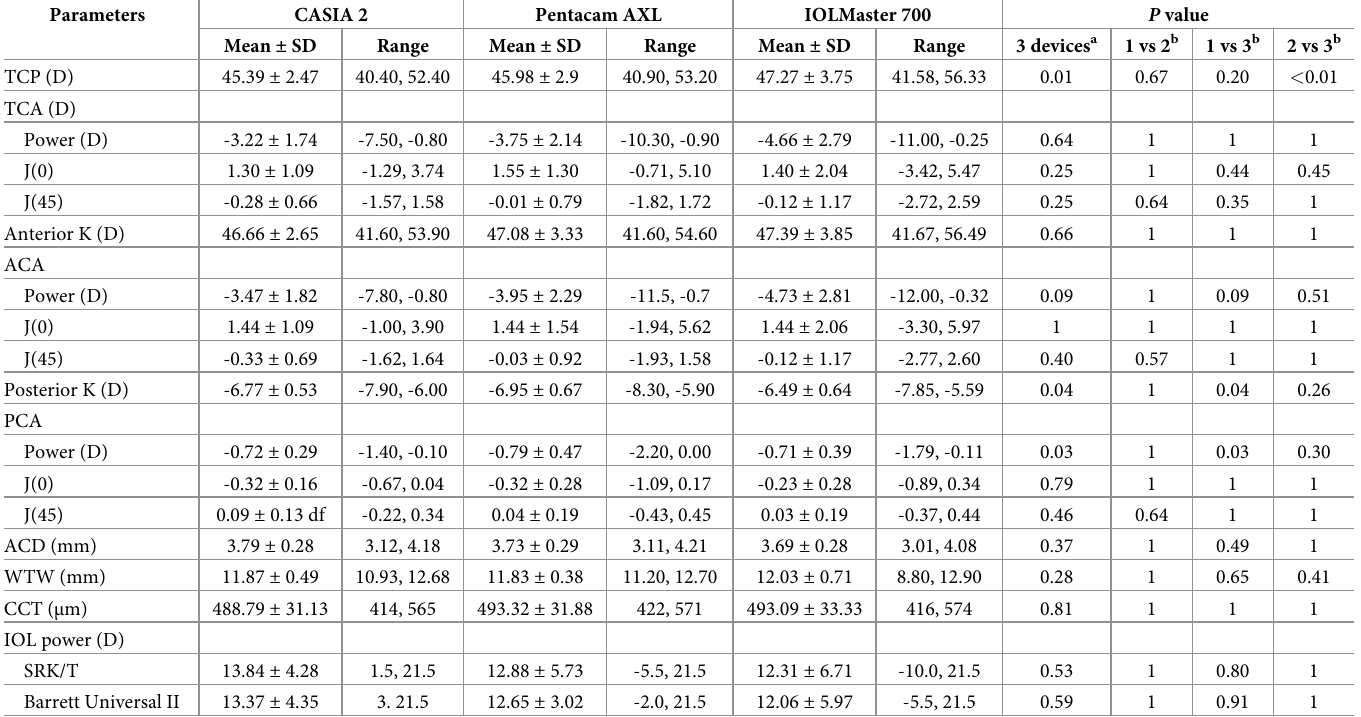
Table 3. Biometric measurements with CASIA 2, Pentacam AXL, and IOLMaster 700 in keratoconic participants.